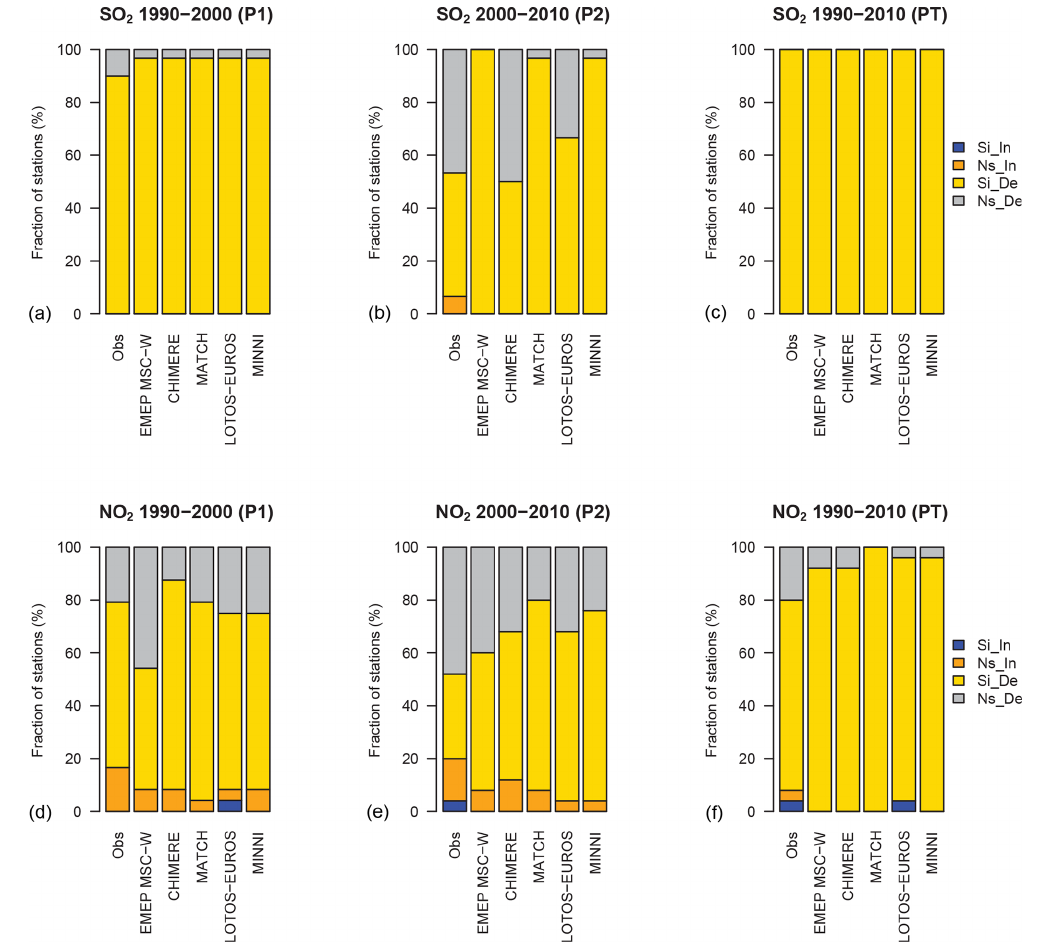
Figure 5. Percentage of statistically significant/non-significant (Si, Ns) increasing/decreasing (In, De) trends in the observations and modeled data for SO 2 (a–c) and NO 2 (d–f) for the P1 (1990–2000), P2 (2000–2010) and PT (1990–2010) periods (from left to right). The number observational sites are 30 and 25 for SO 2 and NO 2 ,